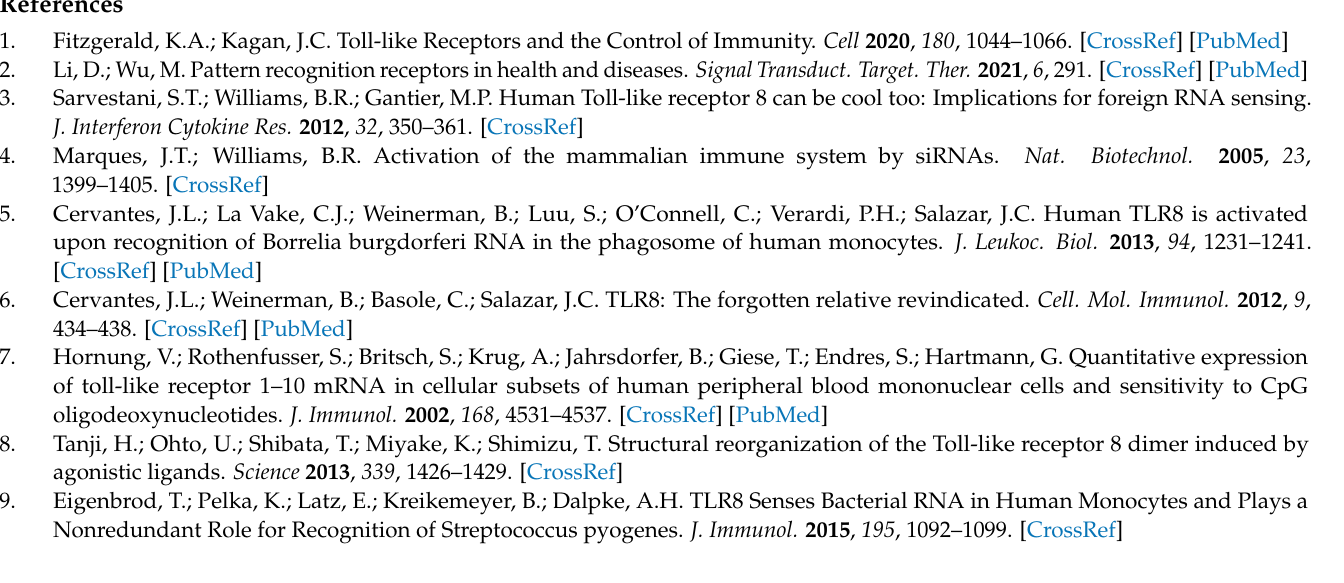
Figure S1: TIRAP silencing in primary human MDMs significantly decreases TLR2- and TLR4- mediated cytokines mRNA expression. Figure S2: TIRAP silencing could be a more relevant approach than knockout to evaluate the fine-tuning of TLRs-mediated signaling by TIRAP. Figure S3: TIRAP silencing reduces STAT1 phosphorylation in LPS- or CL075-stimulated human MDMs. Figure S4: Total phosphorylation pattern of IRF5 in CL075-stimulated cells is not affected by TIRAP silencing. Figure S5: Band shift for IRAK4 protein in TIRAP IPs, induced by the pre-treatment of cells by the PF-06426779 IRAK4 inhibitor, supports the specificity of IRAK4 staining for the selected IPs and WB conditions. Figure S6. Pharmacological inhibition of p38 MAPK does not block the TLR8-induced nuclear translocation of IRF5 or p65, but it still suppresses TLR8-induced cytokine transcription. Figure S7: Tested Akt inhibitors have a similar inhibitory effect on TLR8-mediated IFN β and IL-12A expression. Figure S8: Inhibition of Akt strongly decreased TLR8-mediated phosphorylation of Y701 in STAT1, with no inhibitory effect on TLR4- or TLR8-mediated MAPKs phosphorylation. Figure S9: Akt inhibition had no effect on the total phosphorylation pattern of the IRF5-transcription